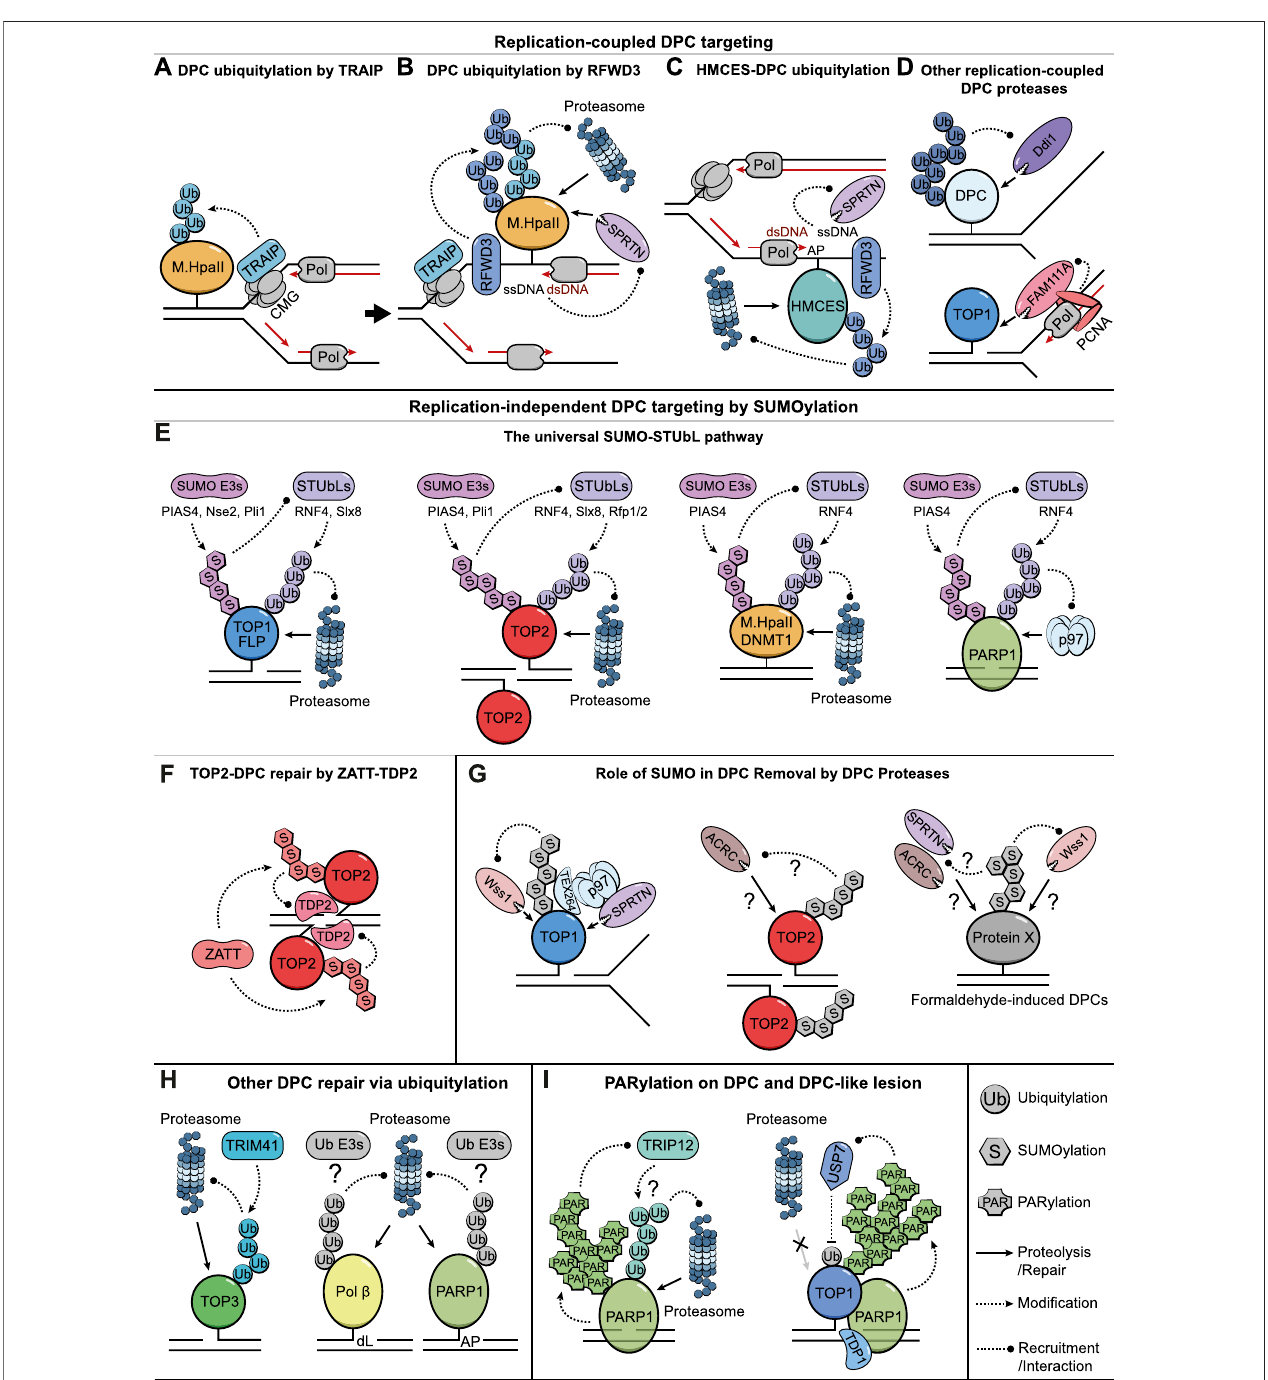
FIGURE 1 | Targeting DPCs for Removal via PTMs. (A) A schematic illustration of TRAIP-mediated ubiquitylation of DPCs that hinder CMG progression. (B) CMG bypass of DPCs exposes ssDNA and likely triggers RFWD3-mediated DPC ubiquitylation that further leads to proteolysis by the proteasome and SPRTN. SPRTN protease is targeted by ssDNA/dsDNA junctions. (C) Putative models illustrating how HMCES-DPCs on AP sites are either ubiquitylated by RFWD3 to undergo proteasomal degradation or targeted by SPRTN via nascent DNA strands extended to the lesion. (D) Ddi1/DDI2 might target DPCs with long ubiquitin chains, presumablyassociatedwithDNAreplication(topillustration).FAM111AdegradesDPCsduringDNAreplication via itsinteractionwithPCNA(bottomillustration). (E) The SUMO-STUbLpathway targetsDPCs to degradation in the absence ofDNA replication and serves asa universal repair solutionfor varioustypes ofDPCs and DPC-like lesions. (F) ZATT-mediated TOP2-DPC SUMOylation facilitates the recruitment of TDP2 to hydrolyze the covalent linkages. (G) Role of SUMOylation in promoting the removalofTOP1/2-DPCsandformaldehyde-inducedDPCsbyDPCproteases. (H) Ubiquitylation-mediatedproteasomaldegradationofcrosslinkedTOP3B,Pol β -,and PARP1-DPCs. (I) PARP1auto-PARylationlimitsPARP1-traping via TRIP12-mediatedubiquitylationandproteasomaldegradation(leftillustration).PARylationstimulates TDP1 recruitment to TOP1-DPCs while also preventing their proteasomal degradation by recruiting the deubiquitylating enzyme USP7 (right illustration).